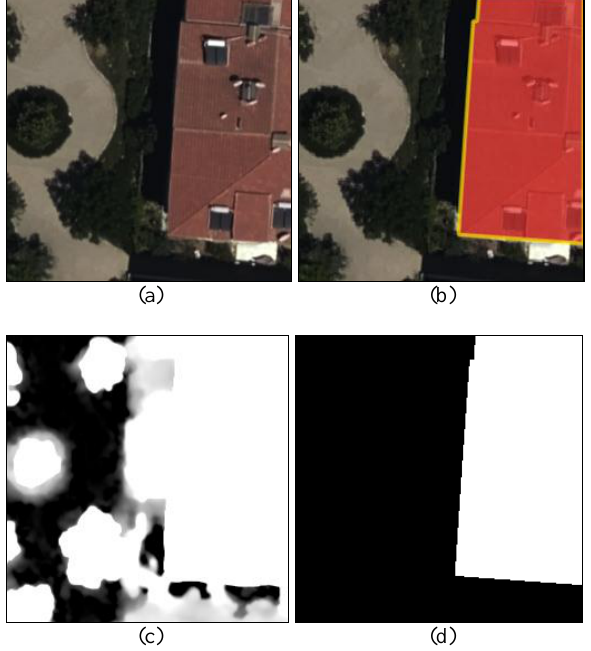
Figure 2. A sample tile from the study area: (a) RGB true orthophoto, (b) building footprint vector, (c), nDSM, and (d) building